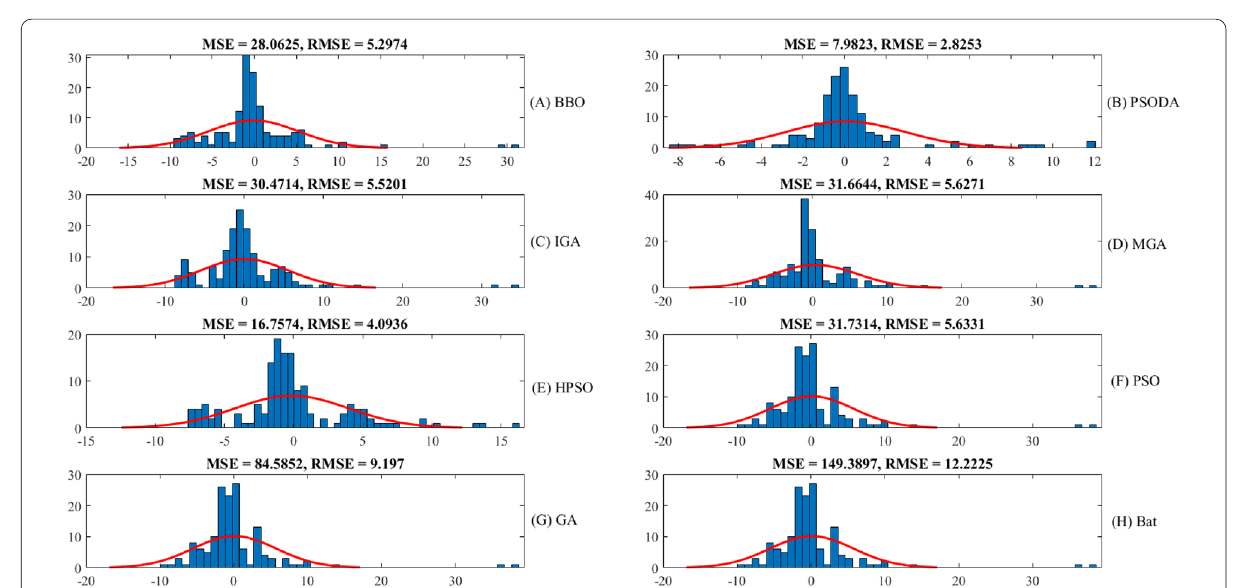
Fig. 14 MSE and RMSE values of different methods for testing dataset.